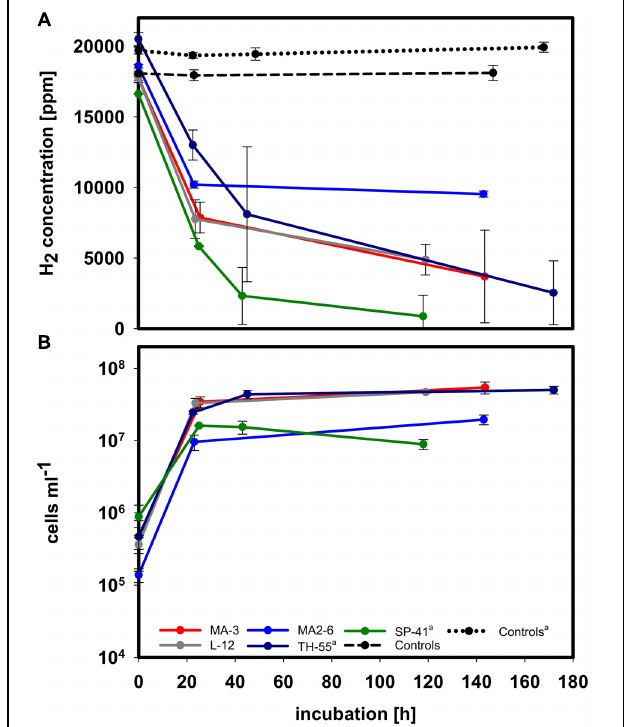
FIGURE 3 | H 2 consumption measurements in MJ-T medium and under an atmosphere of H 2 :CO 2 :O 2 :He (2:20:1:77). All experiments were performed at 28 ◦ C. (A) H 2 concentration in the headspace of all hydrogen consuming species during incubation. (B) Cell density during incubation of the respective species. Exemplarily two sets of controls, non-inoculated medium treated the same way as the samples, are shown. ( a ) Data from Hansen and Perner (2015).